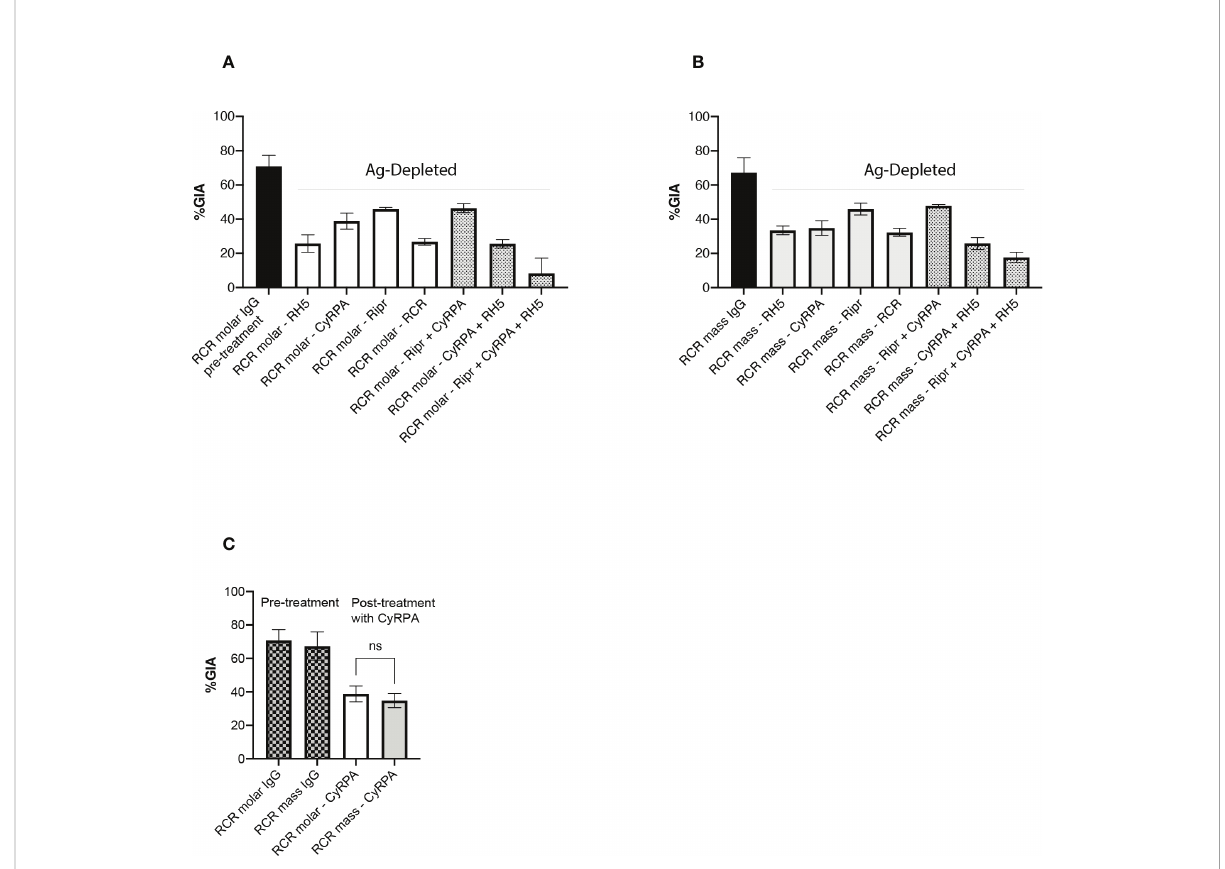
FIGURE 5 Depletion of speci fi c antibodies to determine effect on inhibition of P. falciparum growth. IgG pools were made from the RCR equimolar antigen cohort IgG (A) and RCR mass cohort IgG (B) and incubated with antigens to deplete speci fi c antibodies. Black bars - before depletion with antigen and others after depletion with speci fi c antigen as indicated. Open bars – single antigen treatment (RCR complex is counted here as a single antigen). Hatched bars - antigen combinations. (C) Data extracted from panels (A , B) showing that GIA of RCR equimolar IgG and RCR mass IgG following CyRPA-depletion are not signi fi cantly different from each other. (A – C) Histograms show mean ± SD of two independent experiments (each performed in triplicate wells). ns, not signi fi